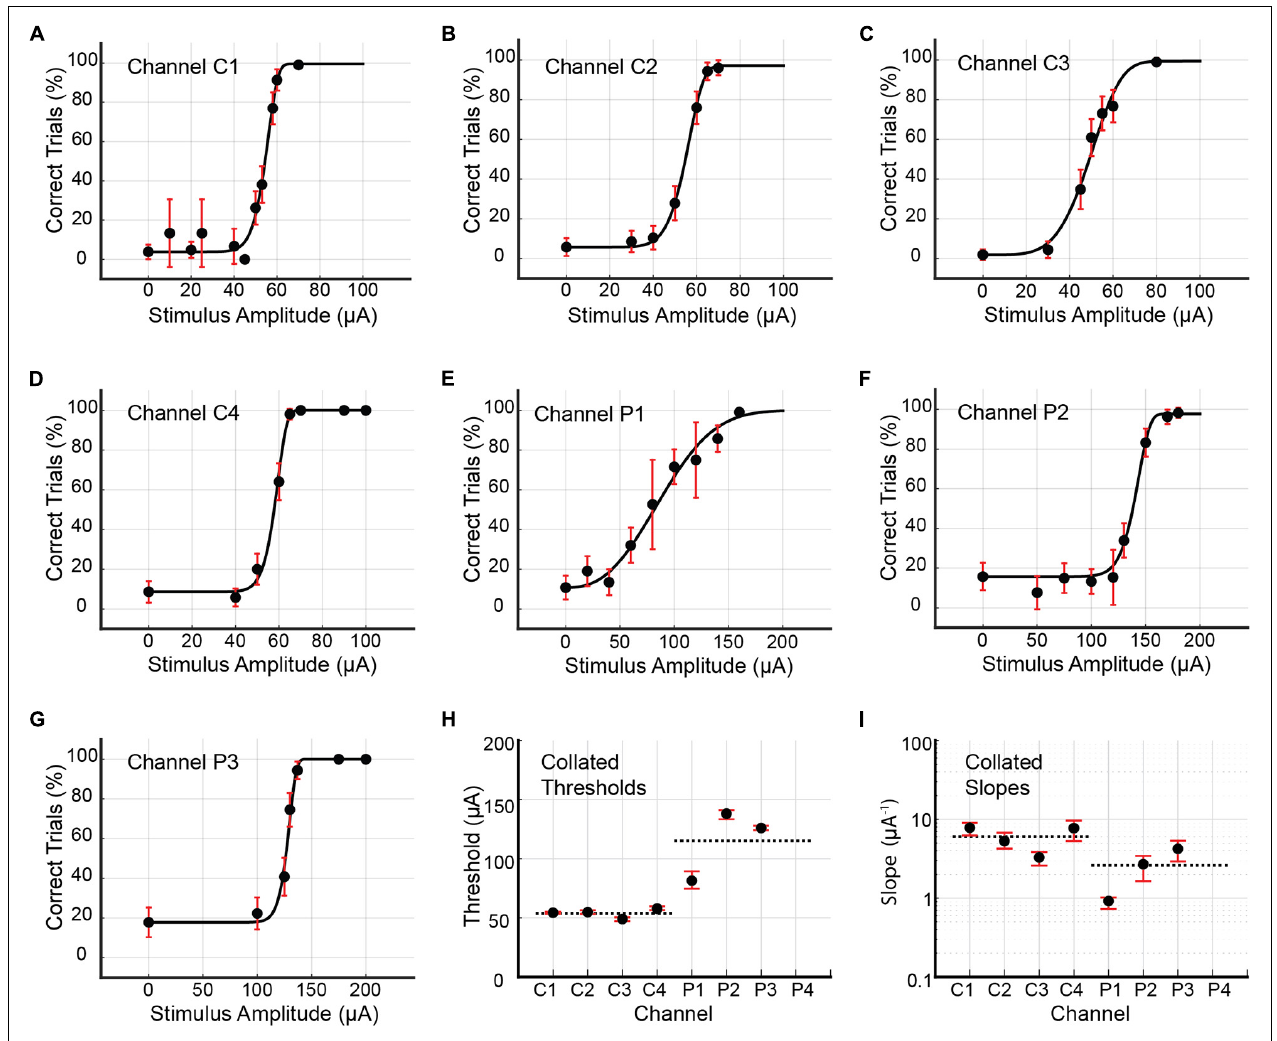
FIGURE 8 | (A–G) Psychometric curves for Rat D generated by single-channel stimulation through individual channels C1, C2, C3, C4, P1, P2, and P3. Single-channel stimulation by channel P4 elicited no leg twitch or behavioral response up to 200 µ A, precluding the generation of a psychometric curve for this channel. Error bars represent 95% confidence intervals for binomial distribution based on detection probability. See Table 4 for fitted parameters, 50% detection thresholds, slopes, and goodness of fit metrics. (H,I) Collated 50% detection thresholds ( x T ) and slopes ( ψ (cid:48) ( x T ) ) extracted from the preceding seven psychometric curves. Horizontal dotted lines depict mean thresholds for core and peripheral channels. Error bars represent 95% BC a confidence intervals.